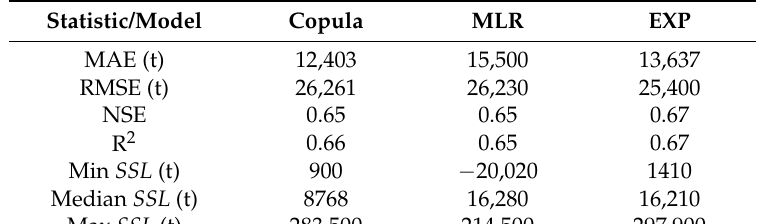
Table 6. Performance criteria results and summary statistics for the estimated SSL values for the Gornja Radgona station on the Mura River.